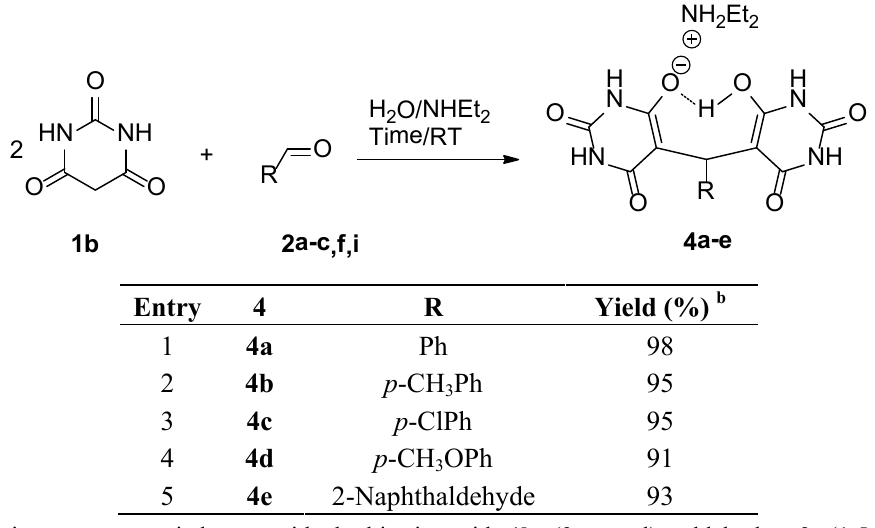
Table 3. Tandem Aldol-Michael reactions of barbituric acid 1b with aldehydes in aqueous diethylamine medium a